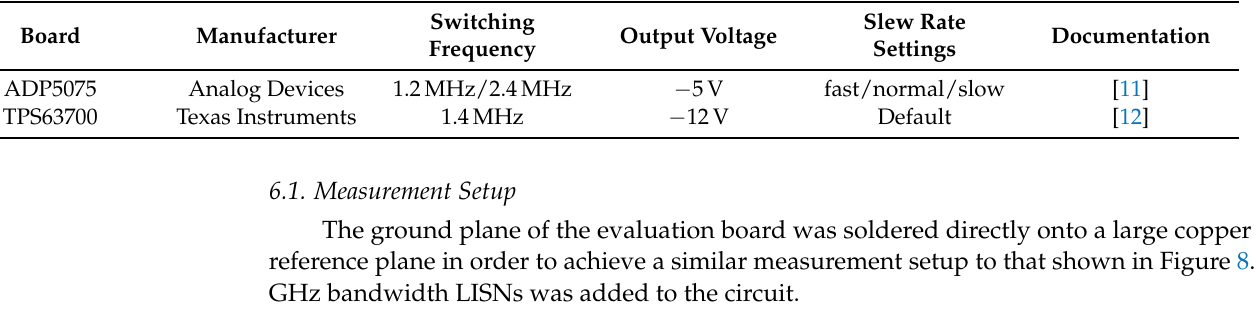
Table 2. Specifications of the different evaluation